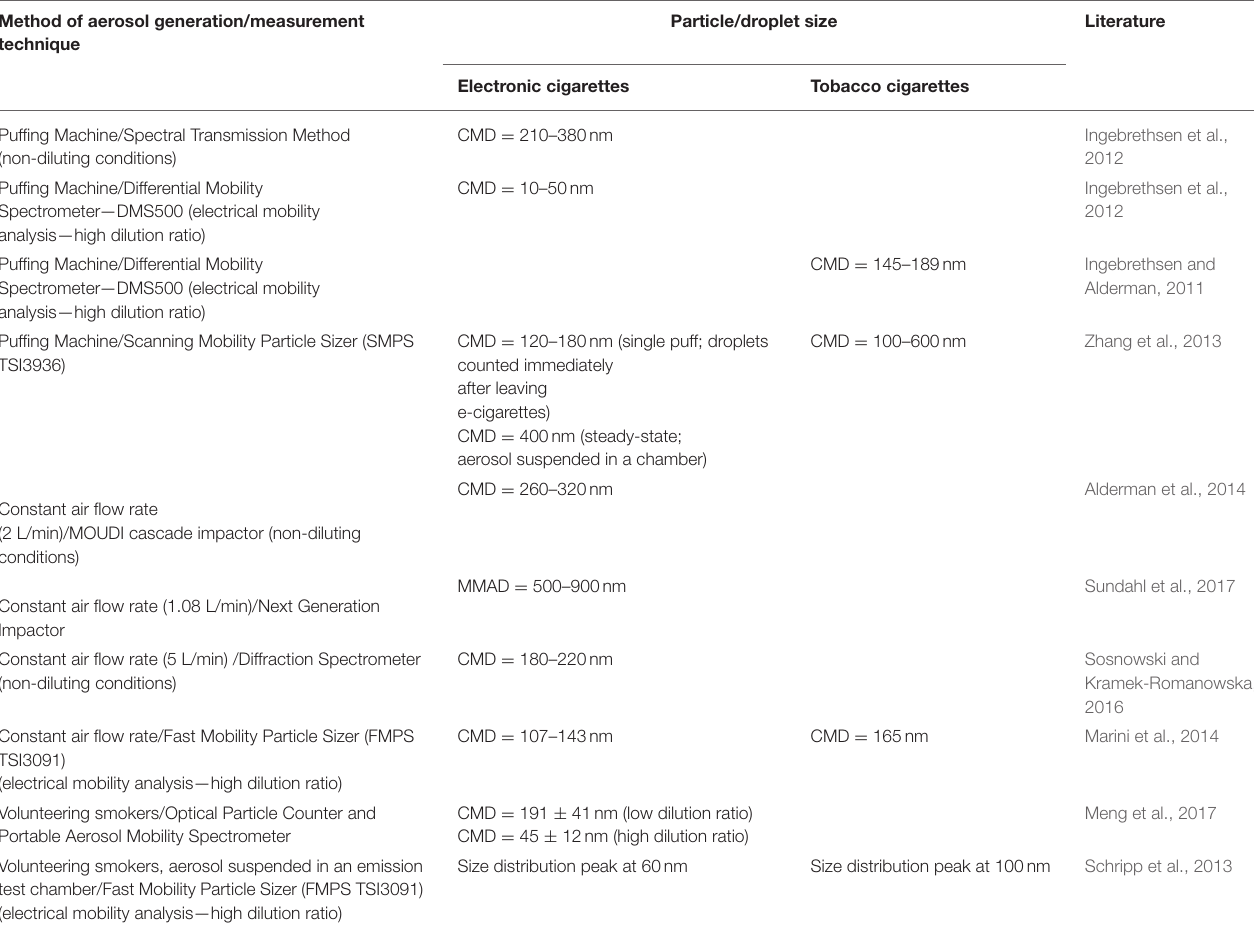
TABLE 1 | Reported particle size emitted from tobacco and electronic cigarettes obtained with different measuring techniques and conditions (CMD, count median diameter; MMAD, mass median aerodynamic diameter). Method of aerosol generation/measurement